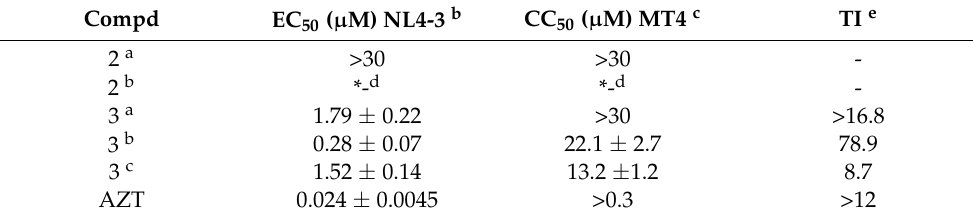
Table 1. In vitro anti-HIV data of synthetic derivatives 2a – b and 3a – c a .